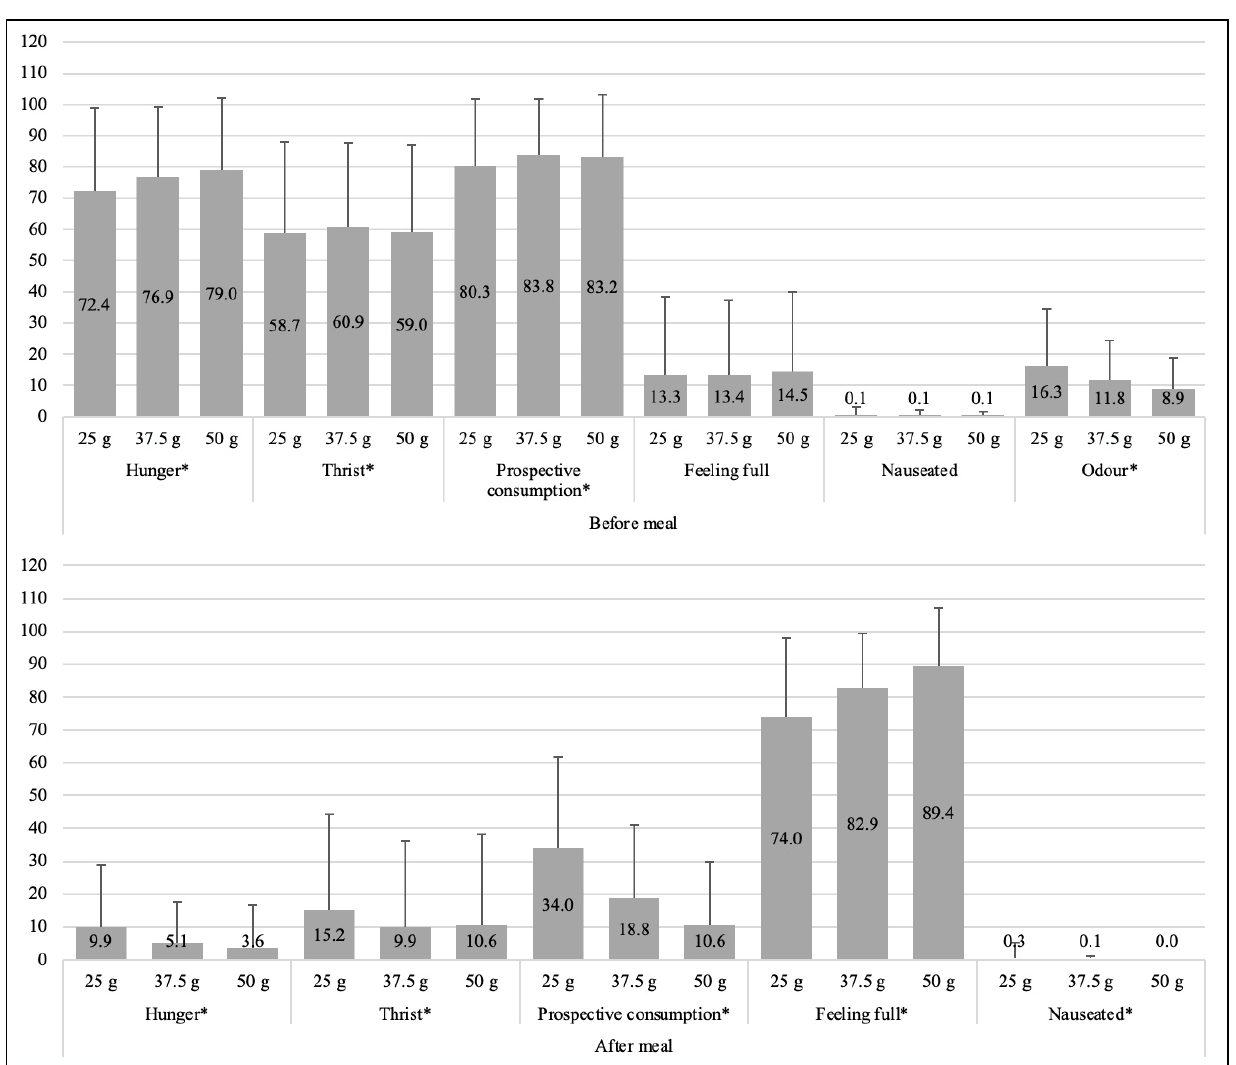
Figure 4. Mean ± SD differences of VAS variables among portion sizes before and after the meals (N = 100). Ratings of VAS scores: 0–100 mm, highest score = intense, lowest score = not at all intense. Differences of VAS scores for 25 g, 37.5 g, and 50 g of daal before and after the meals shows that preference for different portion sizes significantly differed with respect to each VAS variable. This means adolescent girls had different preferences for 25 g, 37.5 g, and 50 g of daal with respect to the parameters of hunger, thirst, prospective consumption, feeling full, and feeling nauseated. * One-way ANOVA test significant at p < 0.001.